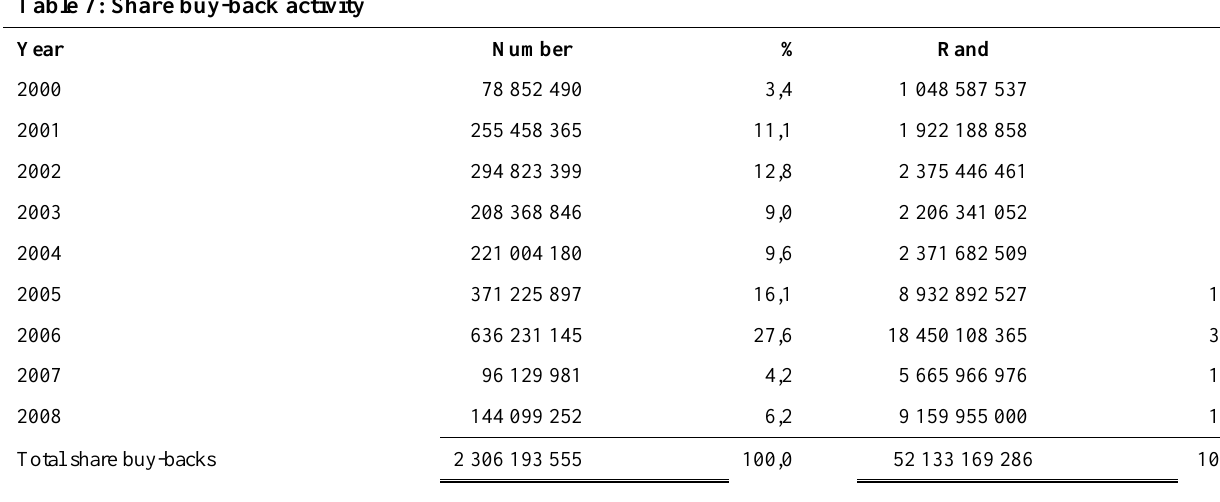
Table 7: Share buy-back activity